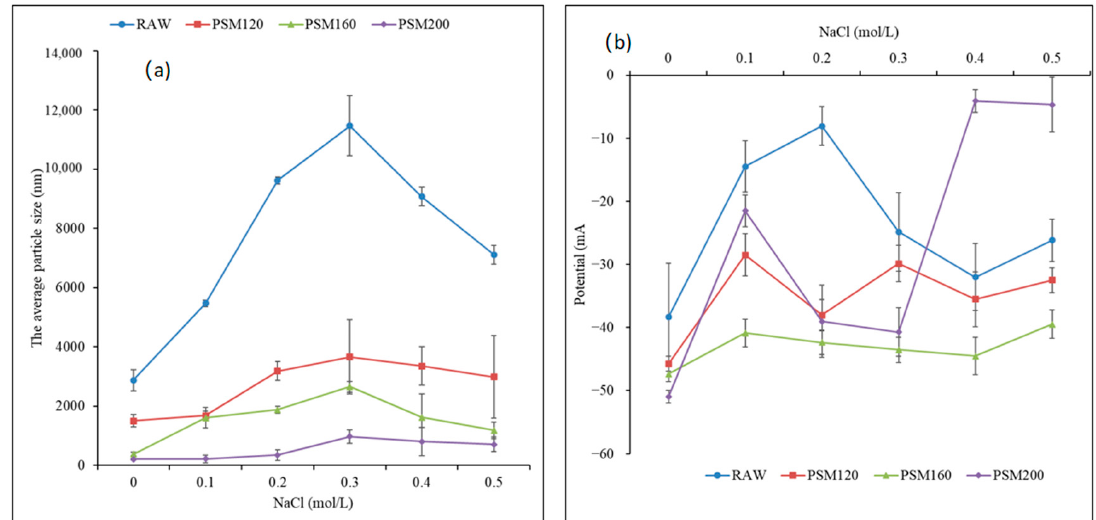
Figure 7. ( a ) Effect of salt concentration on average particle size of PSMs. ( b ) Effect of salt concen- tration on ζ -potential of PSMs. RAW: raw pumpkin seeds, PSM120: pumpkin seeds roasted at 120 °C, PSM160: pumpkin seeds roasted at 160 °C, and PSM200: pumpkin seeds roasted at 200 °C. Different lowercase letters represent the significant difference of the ζ -potential of different pumpkin seed milks at the same salt concentration, and different uppercase letters represent the significant difference of ζ -potential of the same milk at different salt concentrations.